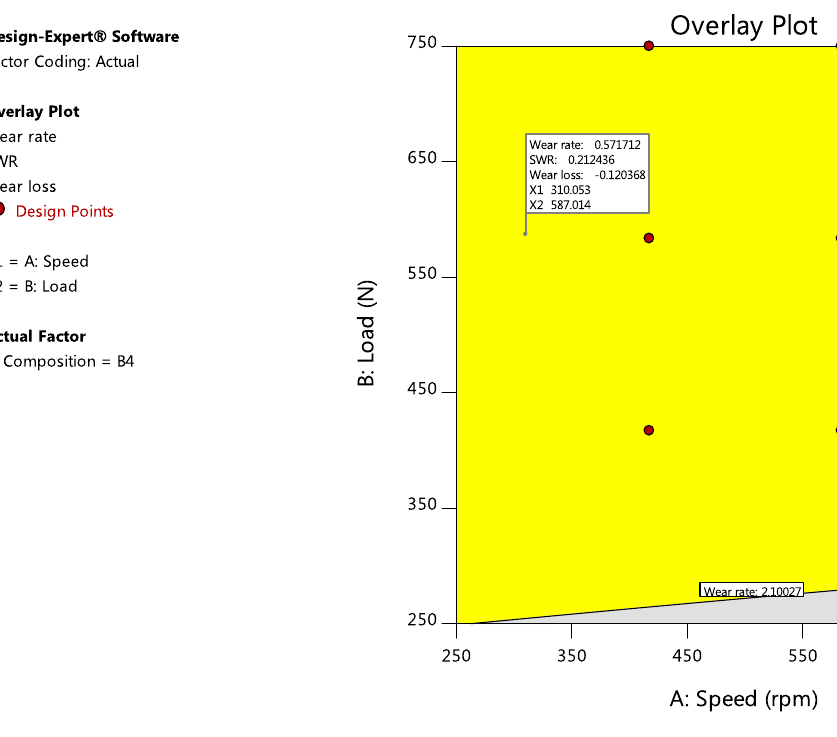
Figure 15. Overlay plot showing the numerical optimization